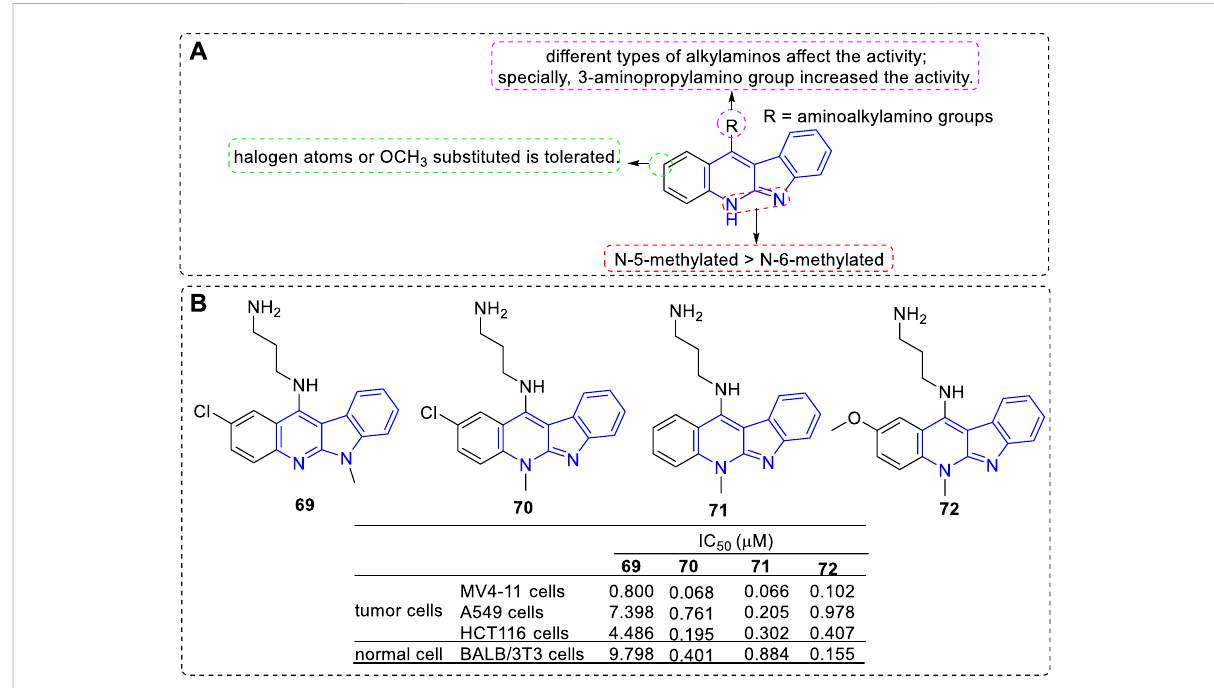
FIGURE 8 (A) SARs of derivatives substituted with aminoalkylamino groups at C-11 position; (B) Structures and bioactivity of the representive compounds 69 – 72